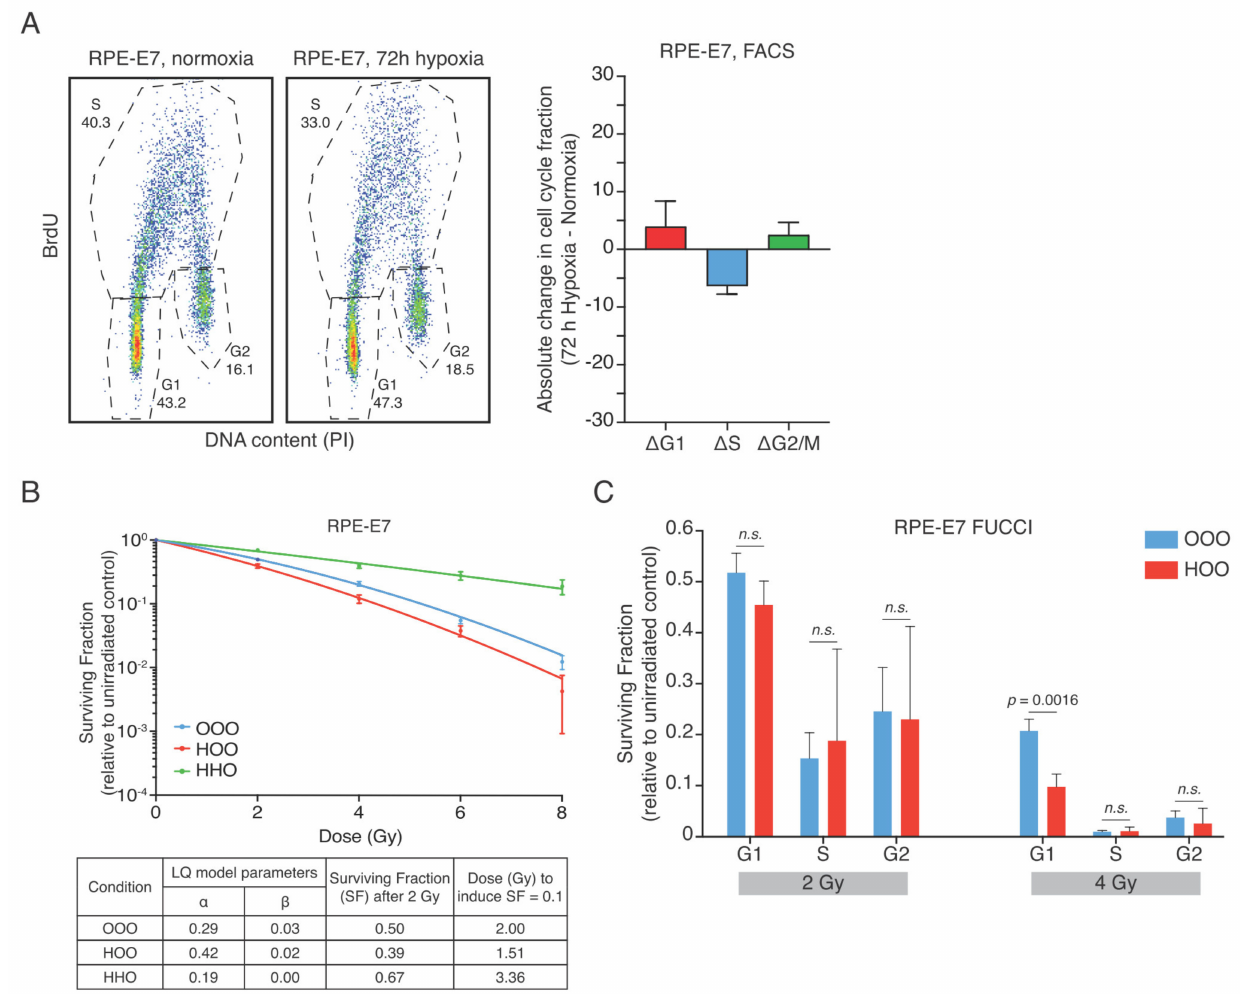
Figure 3. Human papilloma protein E7 prevents the hypoxia-induced G1-arrest and reverses radioresistance after re- oxygenation. (A ) Typical cell cycle distribution of RPE-E7 cells grown for 72 h in normoxic or hypoxic conditions (1% O 2 ). The difference of each cell cycle phase fraction between hypoxic and normoxic cell cycle distribution ( ∆ cell cycle population fraction) is depicted. ( B ) Colony-forming assay of RPE-E7 cells. RPE-E7 cells were irradiated with graded single doses of irradiation after being constantly under normoxic conditions (blue curve—OOO) for 72 h in hypoxia (1% O 2 ) and subsequently irradiated in aerated condition (red curve—HOO) and after 72 h hypoxia and irradiation under hypoxic condition (green curve—HHO). The data were fitted with linear quadratic model, the parameters of the Linear Quadratic model (LQ) of the survival curves are shown collectively for all conditions in a separate table. (Experimental design as in Figure 1A). ( C ) Surviving fraction of different cell cycle phase subpopulations after 2 and 4 Gy is shown. The data represent the mean of three independent experiments, and the error bars the 95% C.I. of the mean. The experimental plan is similar to Figure